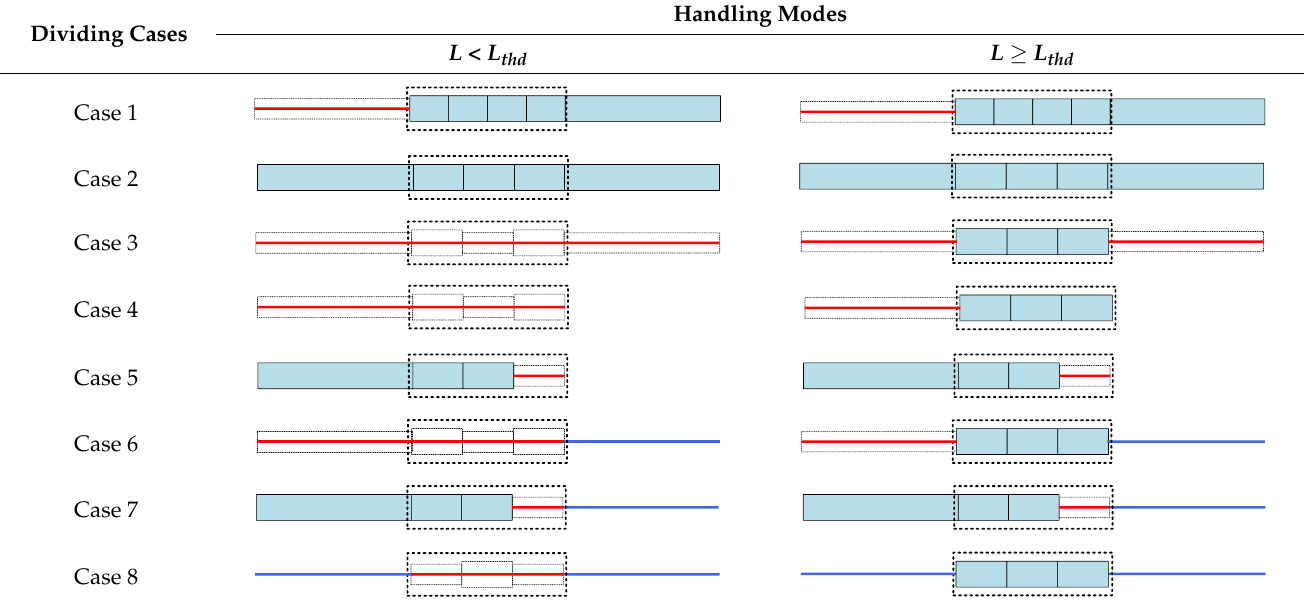
Table 1. Cases of exaggeration priority strategy.